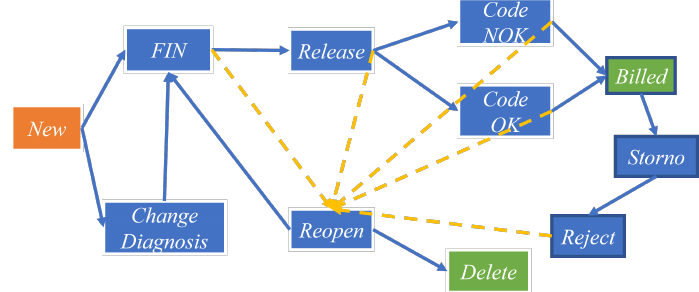
Figure 1. The hospital billing